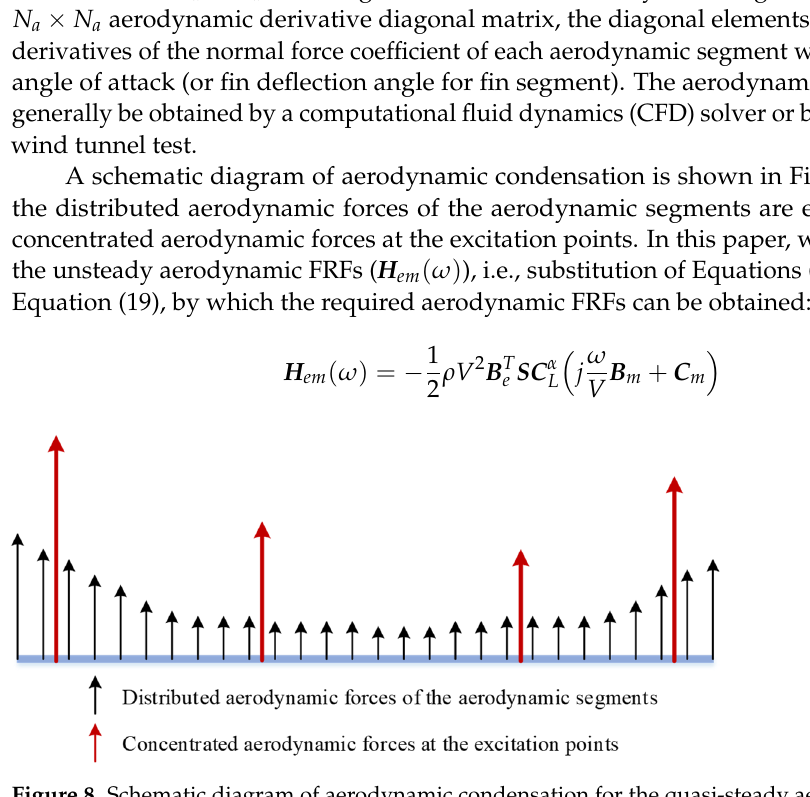
Figure 8. Schematic diagram of aerodynamic condensation for the quasi-steady aerodynamic derivative method.